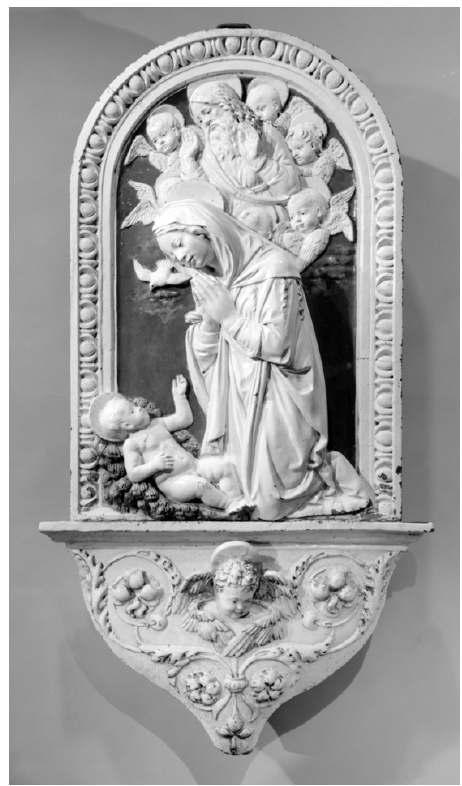
Figure 12. Virgin Adoring the Christ Child, enamel terracotta; workshop of Andrea della Robbia, after 1479 (photo source: Metropolitan Museum of Art, Open Access Policy, public domain).